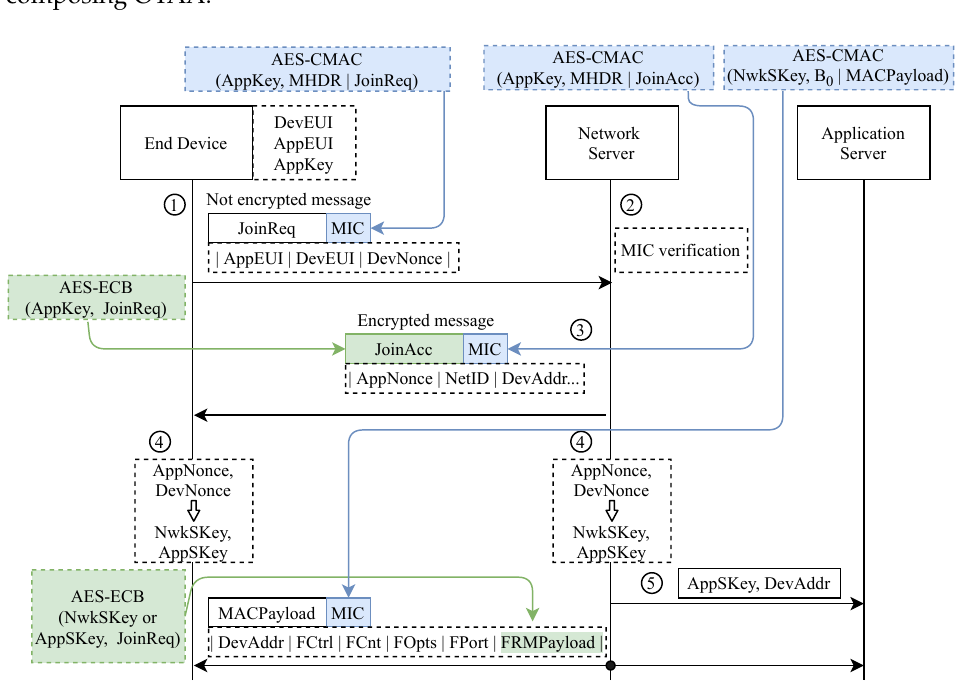
Figure 3. OTAA procedure in LoRaWAN protocol version